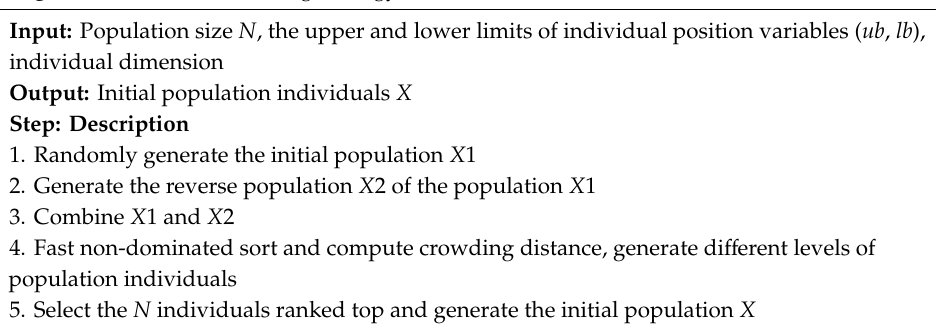
Algorithm 2. Reverse learning strategy.